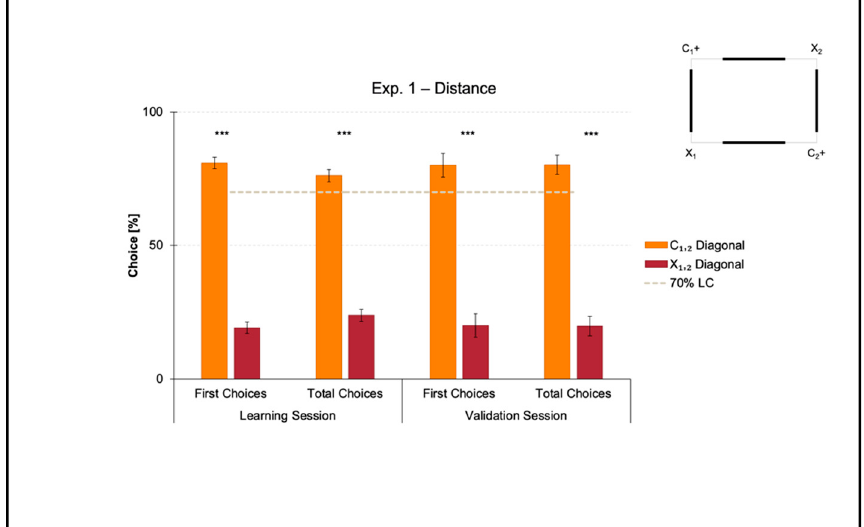
Figure 3. Results of Experiment 1. The bar chart shows the percentages of first and total choices (mean, SEM) obtained by fish towards the two diagonals (C 1,2 versus X 1,2 ) in both learning and validation sessions. The gray dashed line represents the 70% learning criterion (LC), while the asterisks (***) indicate a p- value ≤ 0.001.